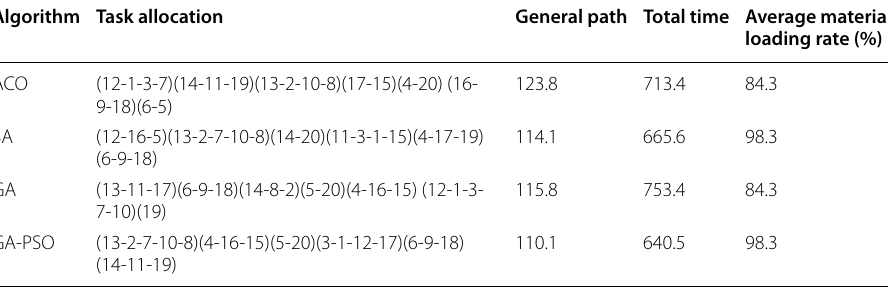
Table 4 Details of the optimal solutions of the second experiment Algorithm Task